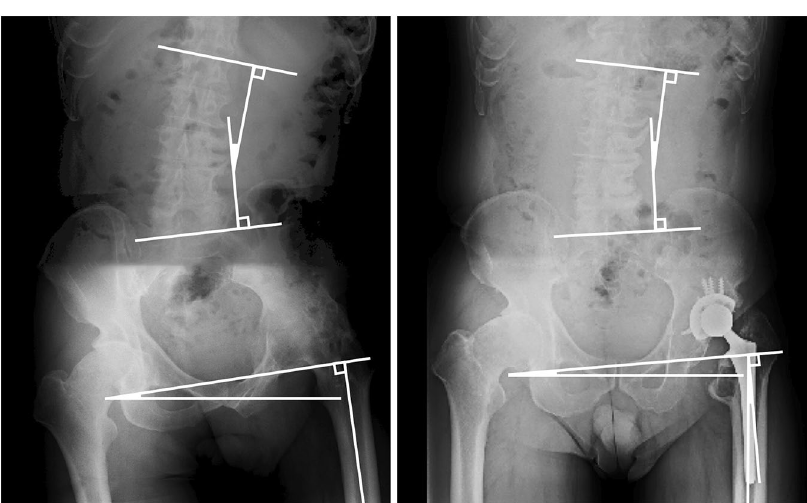
Figure 3. Preoperative and postoperative lumbo-pelvic radiographs. The preoperative LS, PO, HAA, and LLD were 44°, 7°, 0°, and − 1 cm, respectively. The postoperative LS, PO, HAA, and LLD values were 37°, 2°, − 4°, 0 cm, respectively. LS , lumbar scoliosis; PO , pelvic obliquity; HAA , hip adduction angle; LLD , leg length